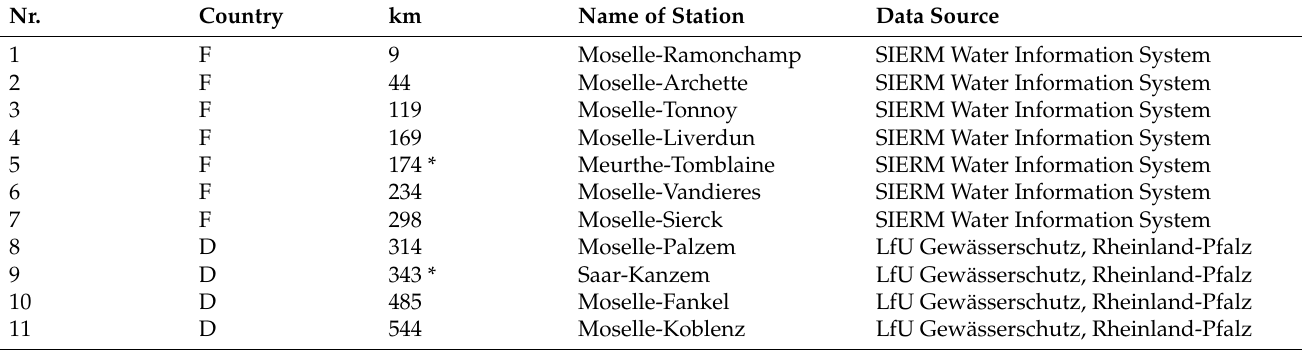
Table 1. List of water monitoring sites addressed in the paper. Locations are indicated in the map above (Figure